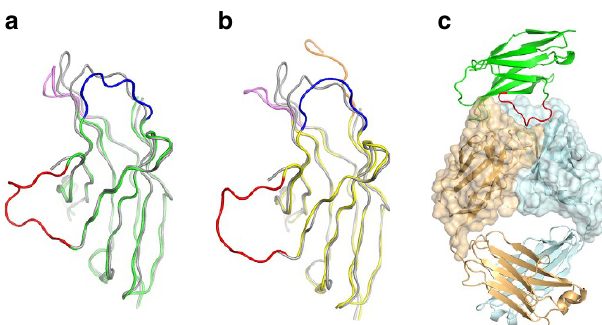
Figure 3 | Conformational changes in the loops of PD-1 induced by the binding of anti-PD-1 antibodies. ( a ) Superposition of PD-1 molecules extracted from the complexes of PD-1/PD-L1 (grey, PDB code 4zqk) and PD- 1/pembrolizumab (green), yielding r.m.s. deviation of 1.26Å. ( b ) Super- position of PD-1 molecules extracted from the complexes of PD-1/PD-L1 (grey) and PD-1/nivolumab (yellow), yielding r.m.s. deviation of 1.38Å. In a and b , the BC, C 0 D, and FG loops of the PD-1 molecule in PD-1/anti-PD-1 are coloured blue, red and violet, respectively. In b , the N-terminal region (residue 27-33) of the PD-1 molecule in PD-1/nivolumab is coloured orange. This N-terminal region in PD-1/PD-L1 and PD-1/pembrolizumab and the C 0 D loop in PD-1/PD-L1 are not shown in the structures due to the lack of interaction. ( c ) Interaction of the C’D loop with pembrolizumab with ribbon repre- sentation of PD-1 (green) in complex with pembrolizumab Fab (heavy chain: pale cyan, light chain: pale orange). Surface of the Fv region of pembro- lizumab is also represented. The C 0 D loop of PD-1 is coloured red.